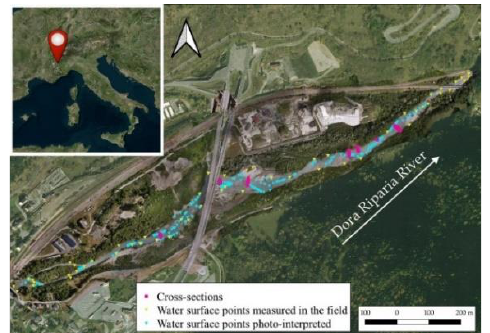
Figure 4. Dora Riparia orthomosaic map. The magenta squares indicate the cross-sections, blue triangles the water surface points manually identified from the orthophoto and yellow triangles the water surface points measured in the